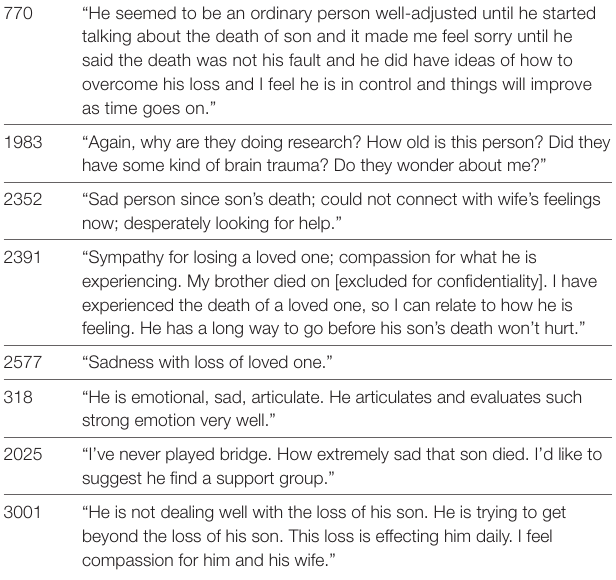
TaBle 4 | Written free responses about empathy induction by patients with damage to the ventromedial prefrontal cortex (vmPFC).